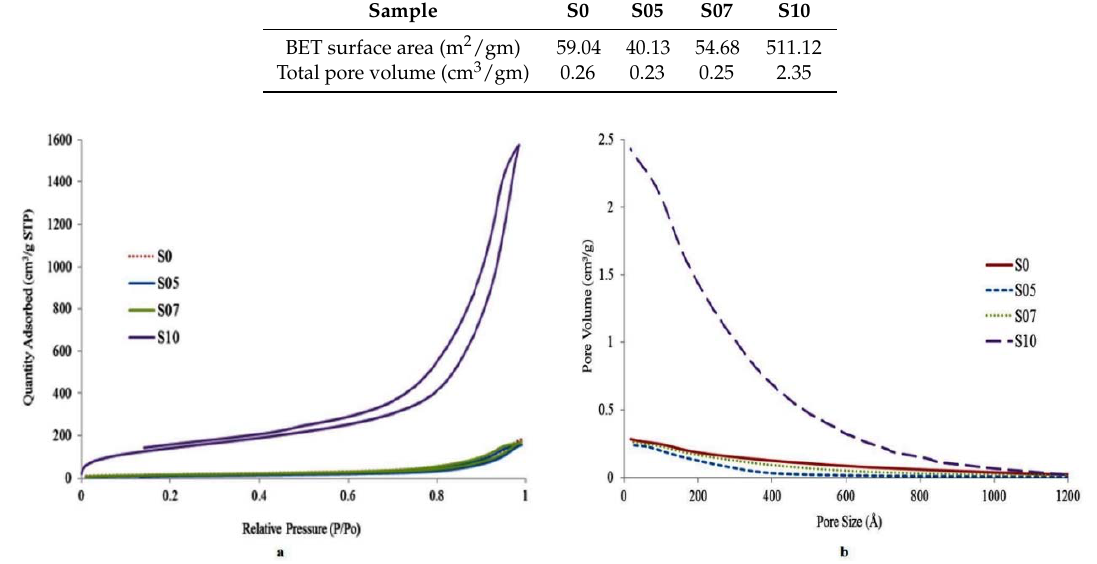
Table 1. Surface areas and pore volumes of neat HNTs and HNTs crosslinked with MA.